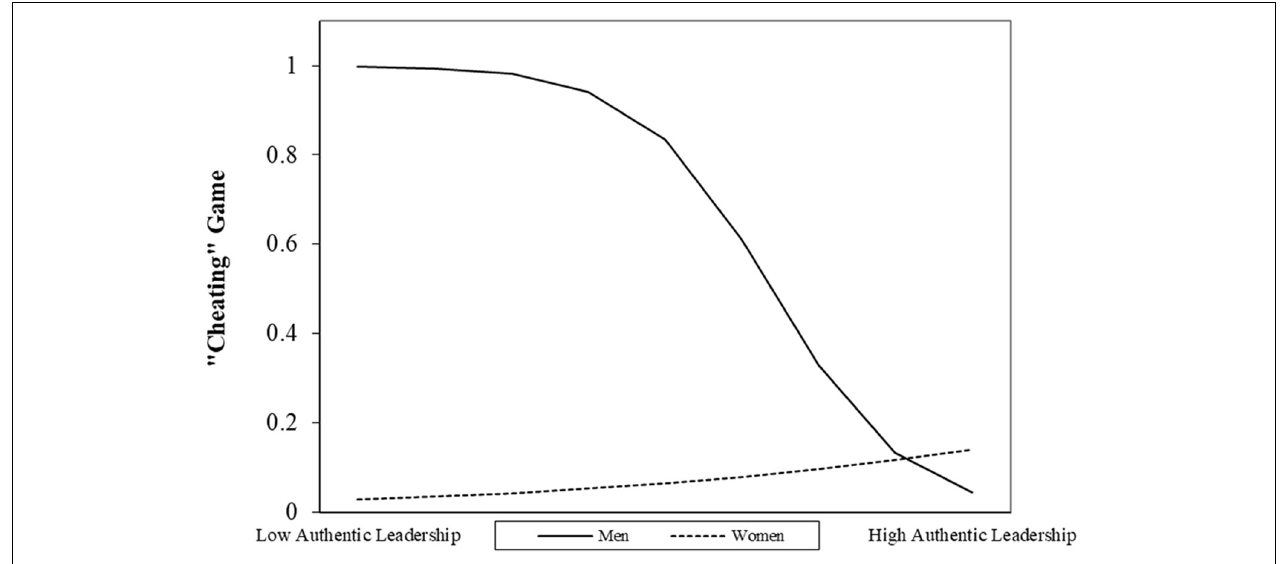
FIGURE 5 | Interactive effects of Authentic Leadership and Anatomical Sex on the likelihood of an affirmative decision in the “Cheating” Game.